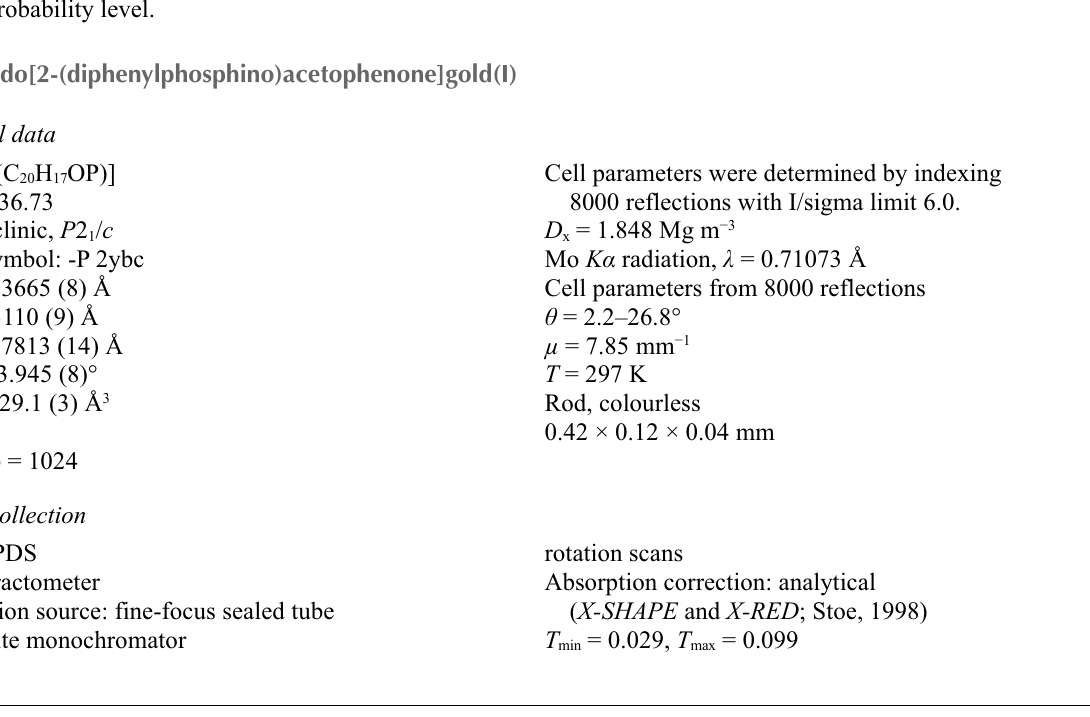
View of the title compound with the atom numbering scheme. Displacement ellipsoids for non-H atoms are drawn at the 50% probability